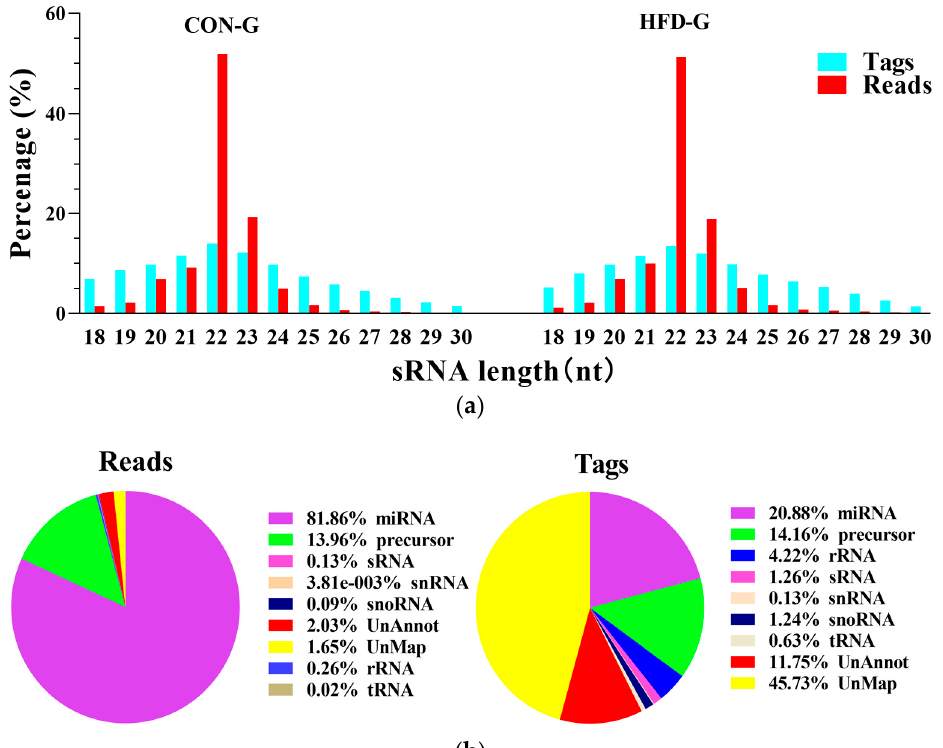
Figure 1. Quality analysis of small RNA sequencing. ( a ) Distribution and abundance of small RNA sequence lengths (18 to 32 nt) in clean reads of skeletal muscle tissue samples from rabbits in CON–G and HFD–G; ( b ) statistical distribution of small RNA annotations. Left, classification statistics of all small RNA reads; right, classification statistics of small RNA tags. Table 1. Quality statistics for data generated from small RNA deep sequencing.